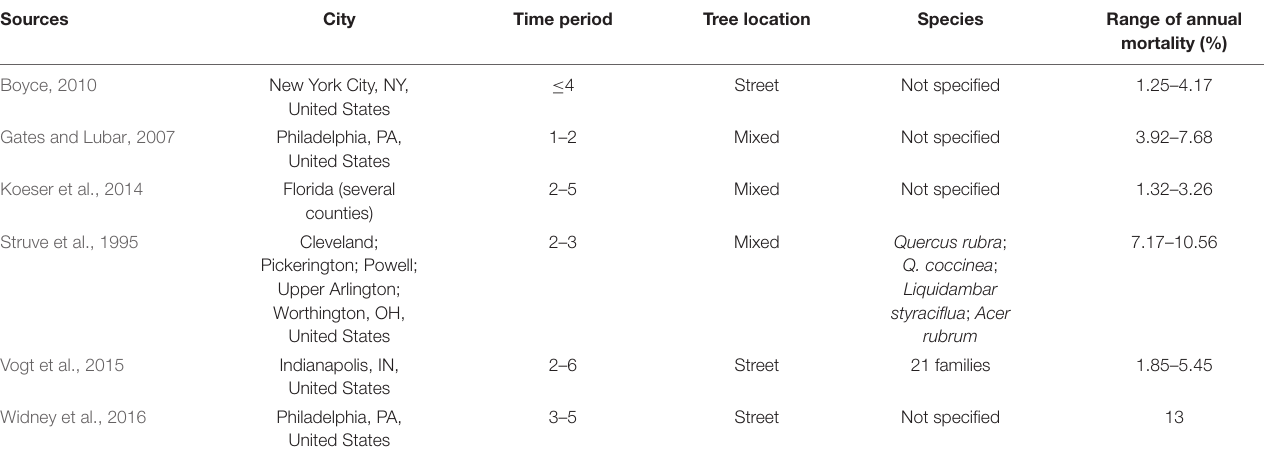
TABLE 3 | Range of annual mortality for cohort studies of trees in highly managed urban